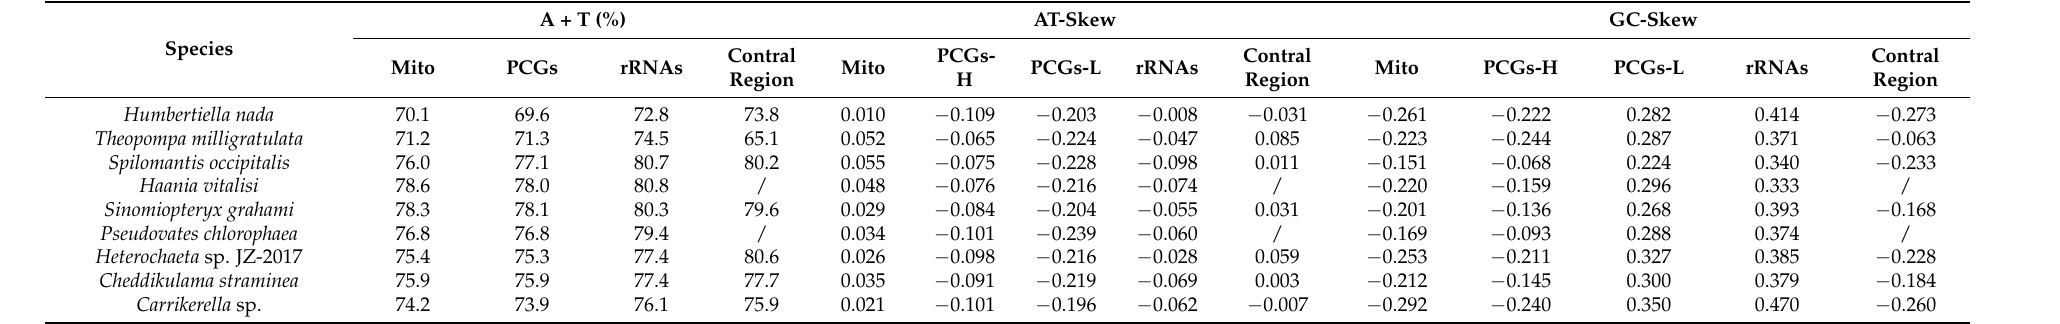
Table 1. Base composition of nine mantis